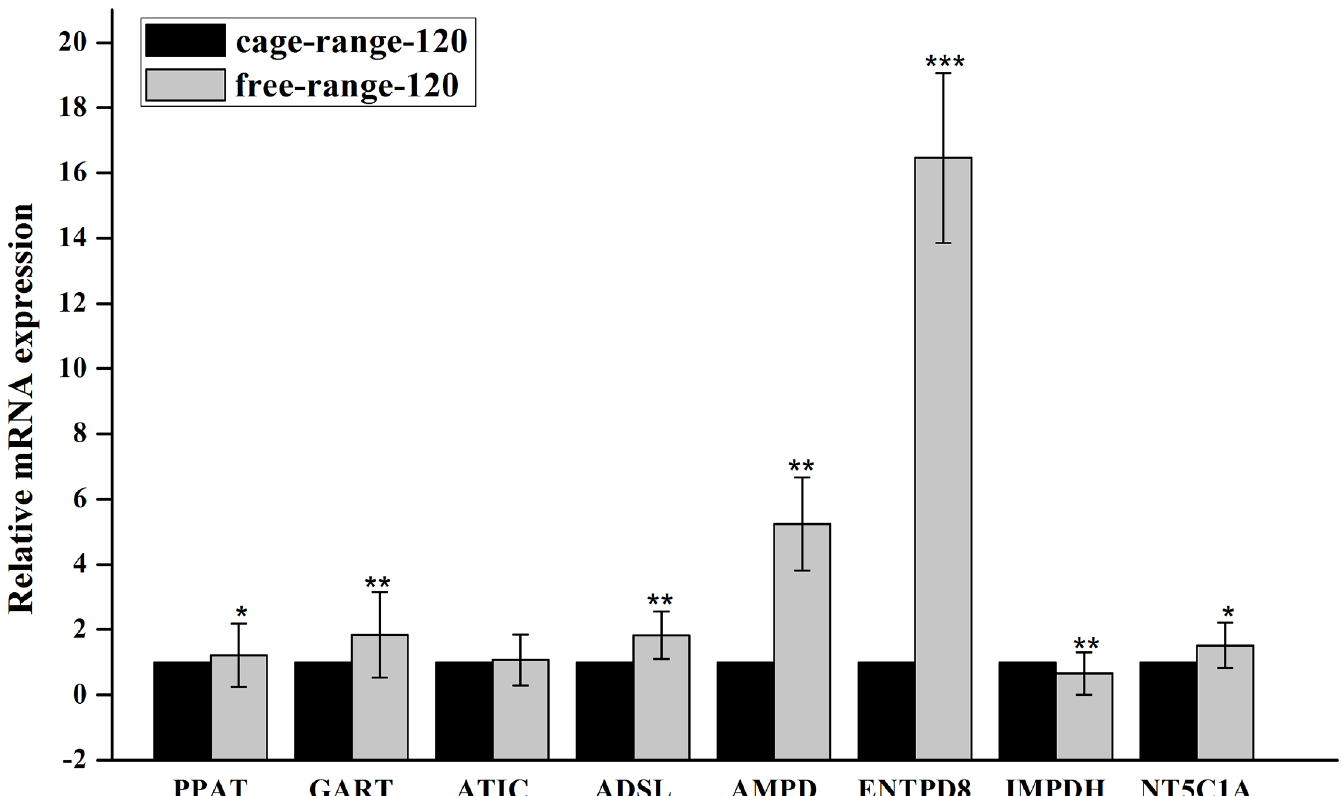
Fig 6. Expression of seven IMP-related genes validated by qPCR in thigh muscles from 120-day-old caged and free-range chickens.